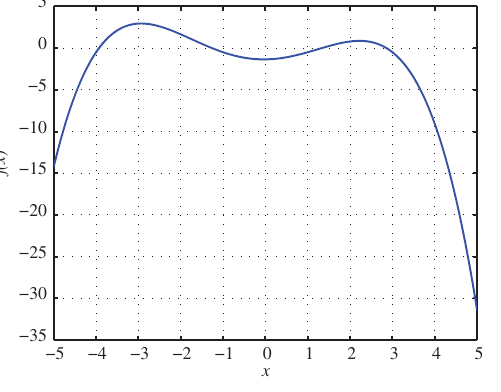
Fig.12. f ( x ) = − 1 / 14( x + 4)( x + 1)( x − 1)( x − 3) − 0 . 5 . Proper- ties: continuous, nonlinear, unconstrained, nonconvex, local optima, univariable.